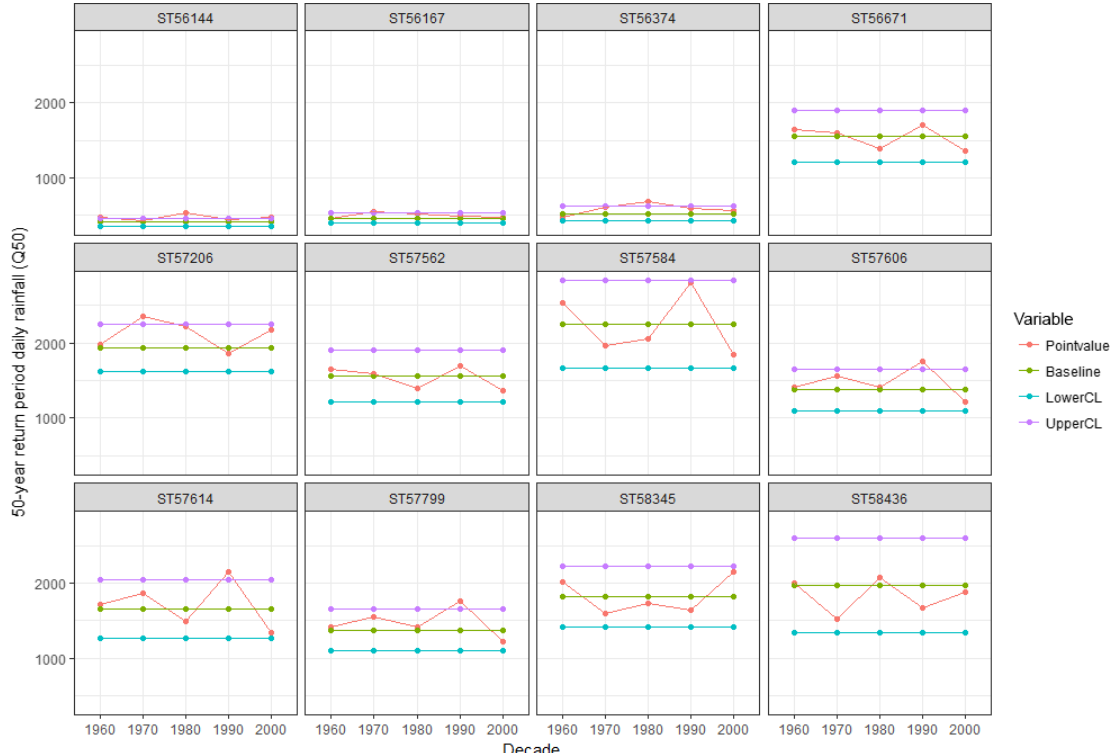
Figure 4. P 50 (mm) for selected decades together with 95% confidence intervals to define statistically significant